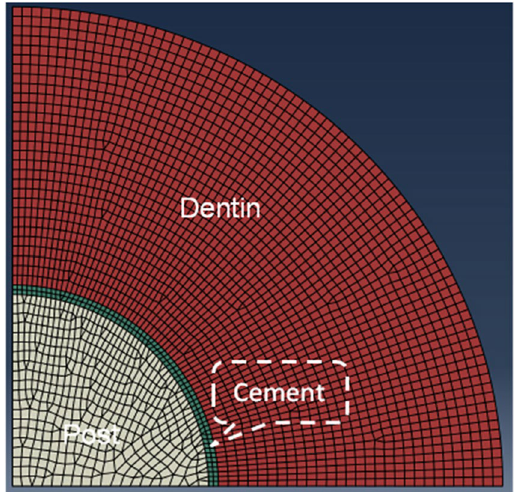
Figure 6. FEA model for the diametral compression (DC) test. Due to symmetry, only a quarter of the disk needs to be